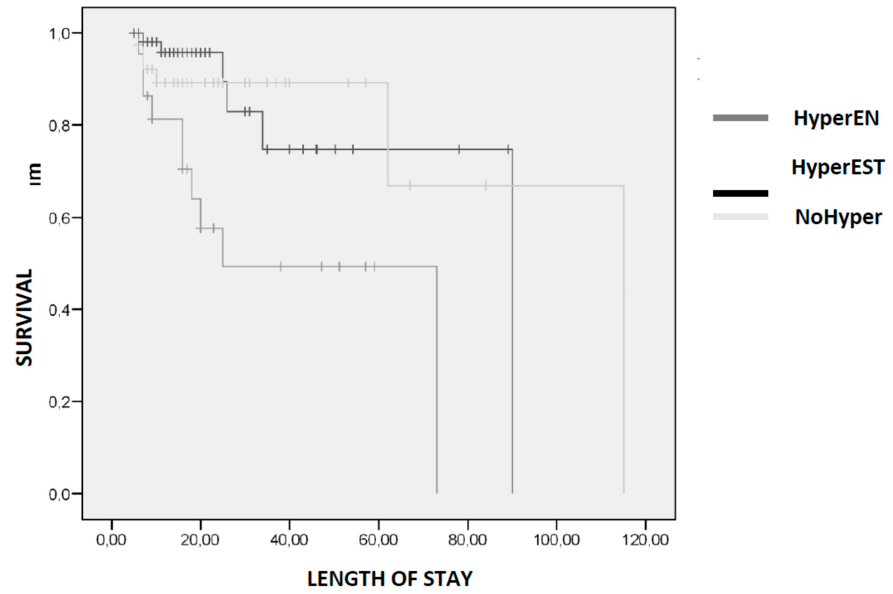
Figure 4. Kaplan–Meier curves comparing survival during admission included patients who developed hyperglycaemia associated with enteral nutrition (HyperEN), those who developed hyperglycaemia of stress (HyperEST), and those who did not develop hyperglycaemia (NoHyper). In our sample, 56 (48.7%) recovered oral feeding. The differences according to the development of hyperglycaemia associated with the enteral nutrition are shown in Figure 1.